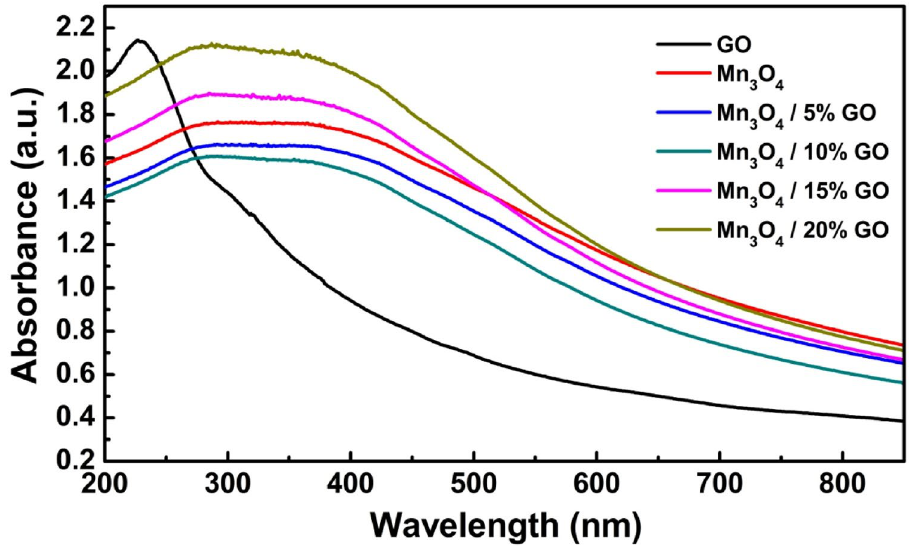
O /x%GO NC’s 3 4